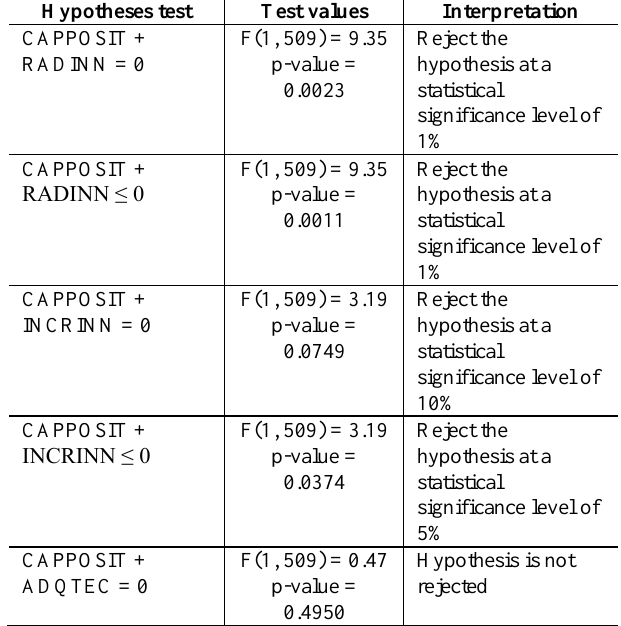
Table 3: Hypothesis tests of some coefficients of model